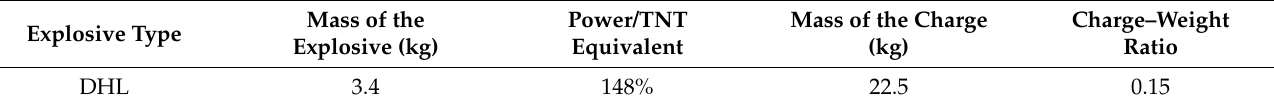
Table 1. Parameters of the charge.